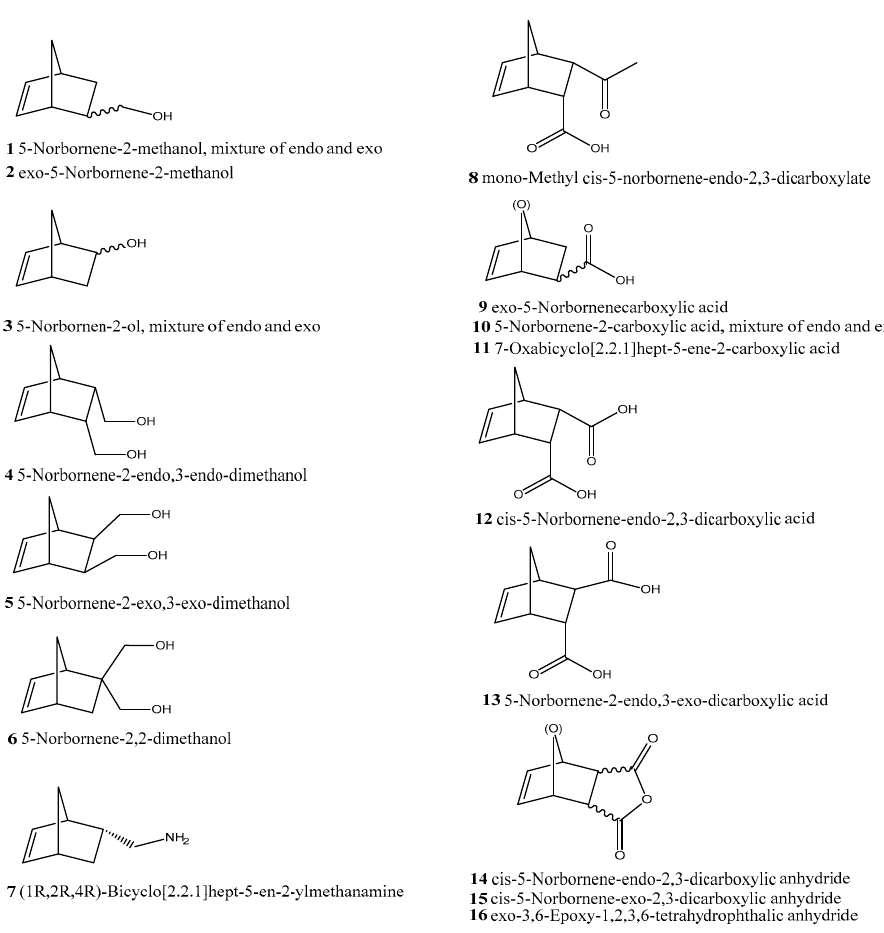
Figure 9. Most commonly used commercially available norbornene derivatives.